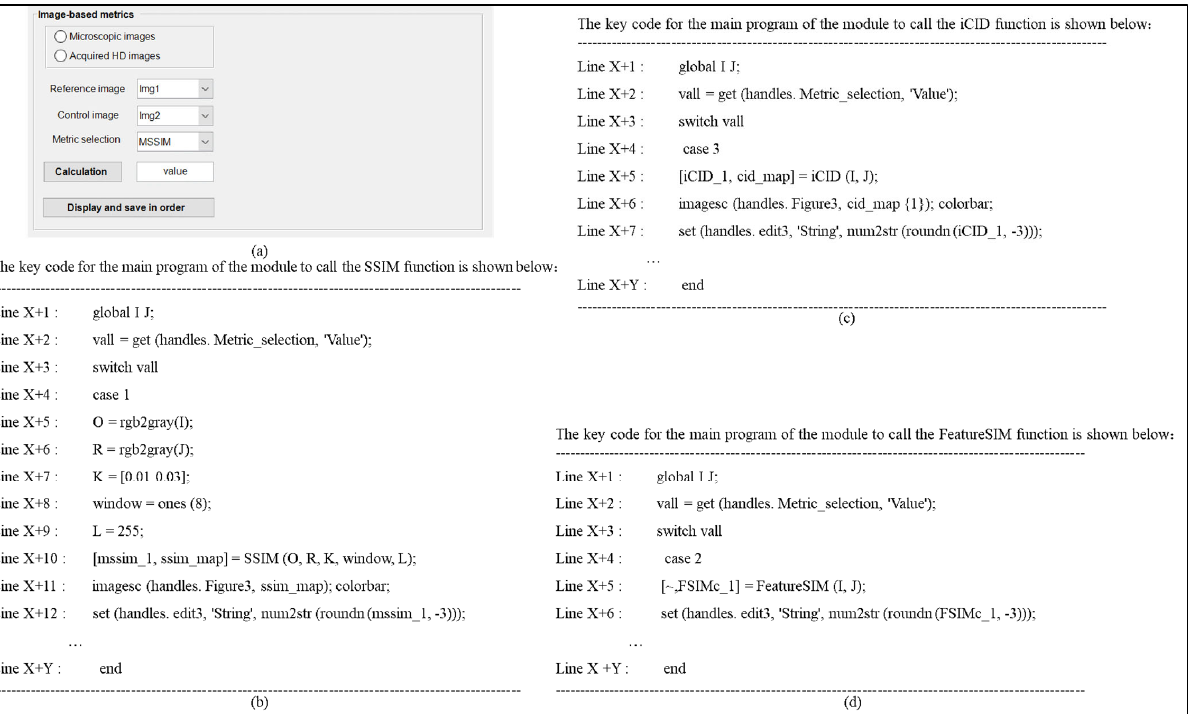
Figure 13. Interface design and demonstration of its calling codes in Module 3: ( a ) initial Interface; ( b ) color SSIM metric; ( c ) iCID metric; ( d ) color FSIM metric. Table 3. Types, labels, and roles of controls used in the Module 3 interface. Type of Controls